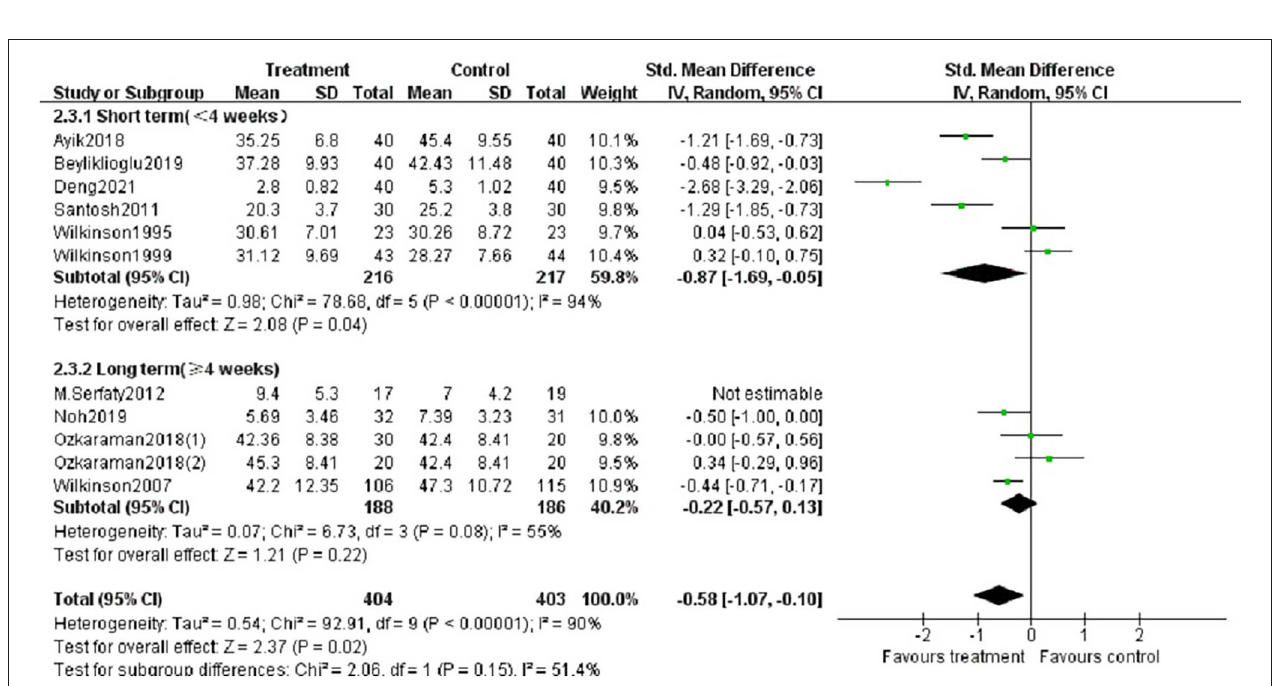
FIGURE 8 | Subgroup analysis according to the type of aromatherapy intervention.